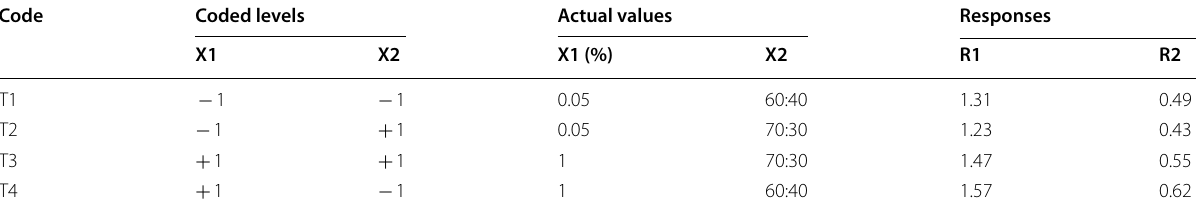
X1 -conc. of acetic acid (%); X2- mobile phase ratio, R1 -tailing factor, R2- peak width